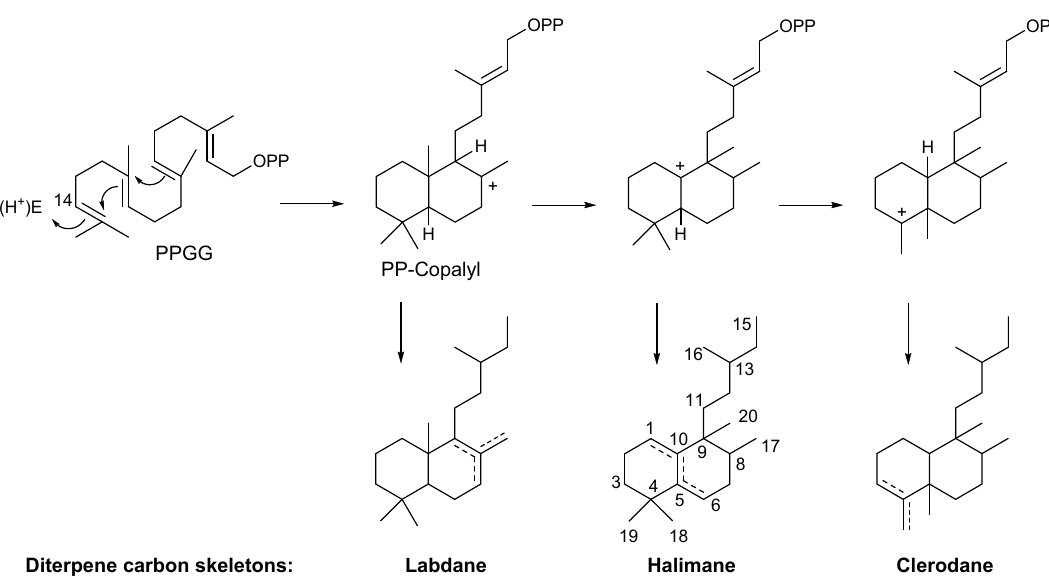
Figure 2. Biosynthesis of some bicyclic diterpenes.